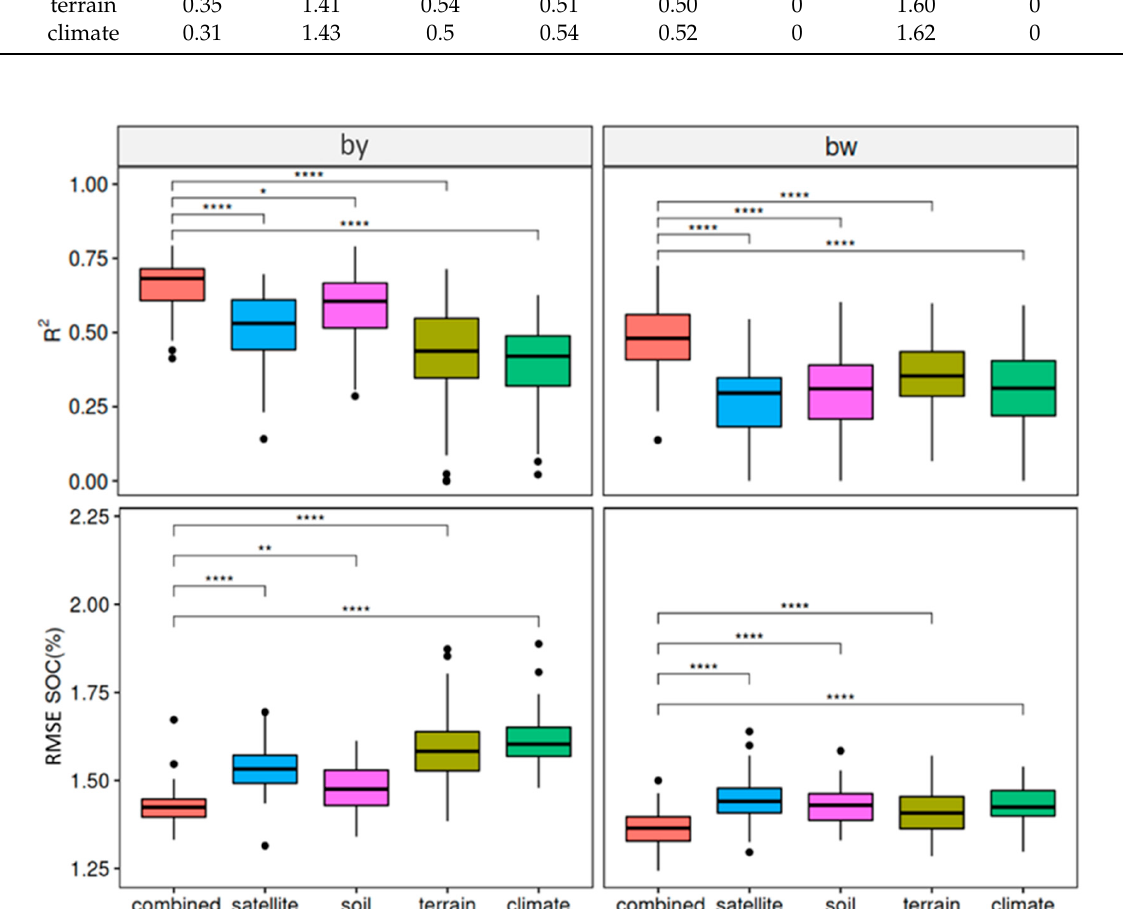
Figure 3. Boxplots (R 2 and RMSE) of the baseline models. Significant differences between combined Figure 3. Boxplots ( R 2 and RMSE) of the baseline models. Significant differences between combined models and the other covariate groups are indicated with stars (* p < 0.5; ** p < 0.01; **** p < 0.0001). models and the other covariate groups are indicated with stars (* p < 0.5; ** p < 0.01; **** p < 0.0001). Table 5. Cross-validation results (R 2 , RMSE, CCC, MAE, and OOB) of the baseline and transferred Scatter plots of predicted and measured SOC values are illustrated in Figure 4. The models in both states. models in BW showed a clear tendency to overestimate low and underestimate high values. Some models in BY had the same issue but a general underestimation of middle to high values seems to be apparent in most models. Soil and combined models produced the best results for high SOC values in BY and therefore also the overall highest R 2